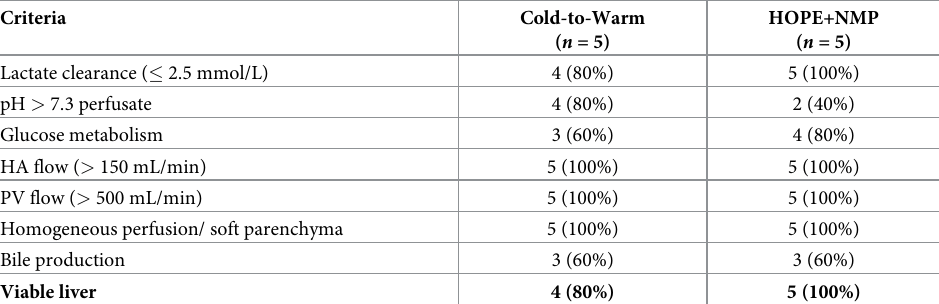
Table 3. Viability criteria achievement by the livers in each group.